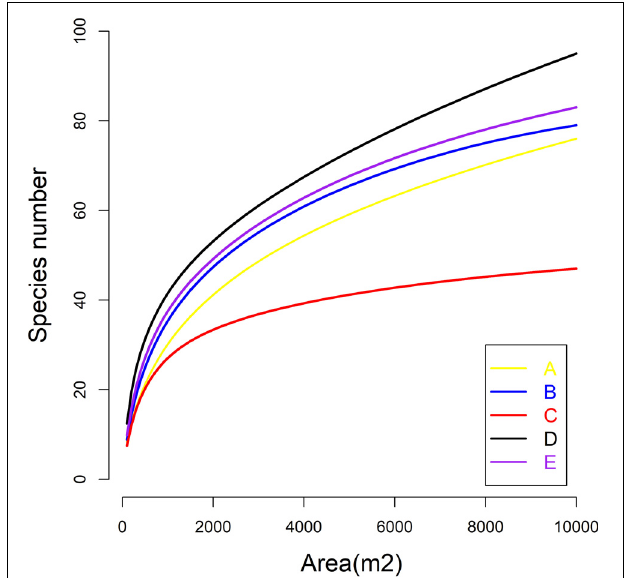
FIGURE 2 | Species accumulation curves of five communities. A, B, C, D, and E were the Quercus variabilis community, Quercus glandulifera var. brevipetiolata community, Mixed broadleaf-conifer community, Quercus aliena var. acutiserrata community, and Miscellaneous wood community,